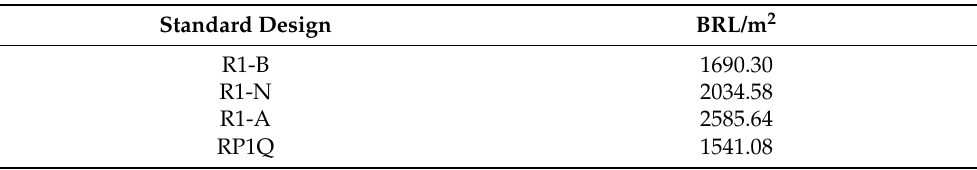
Table 1. The basic unit cost of construction (CUB) in Pernambuco state (January 2021) in Brazilian Real (BRL).